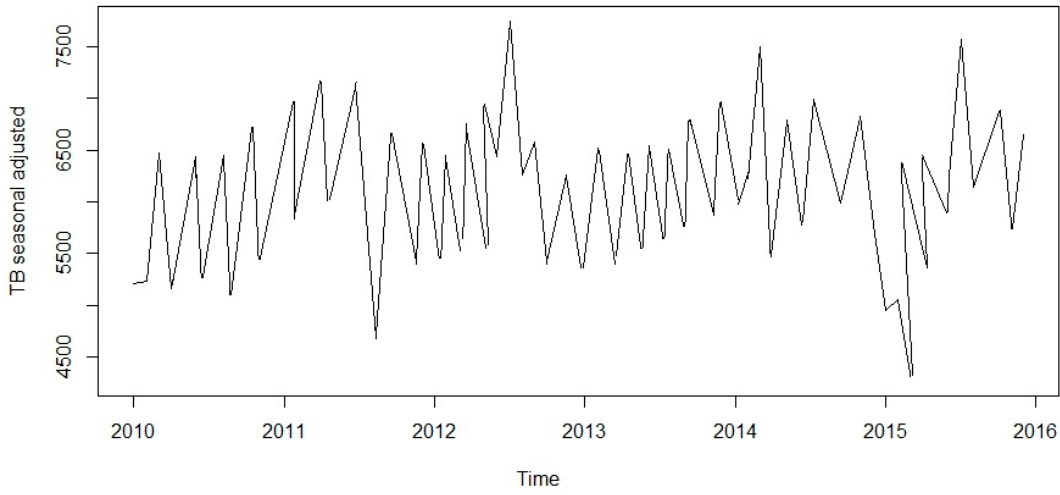
Figure 4. Seasonally adjusted values showing the effects on the monthly reported TB case prevalence.